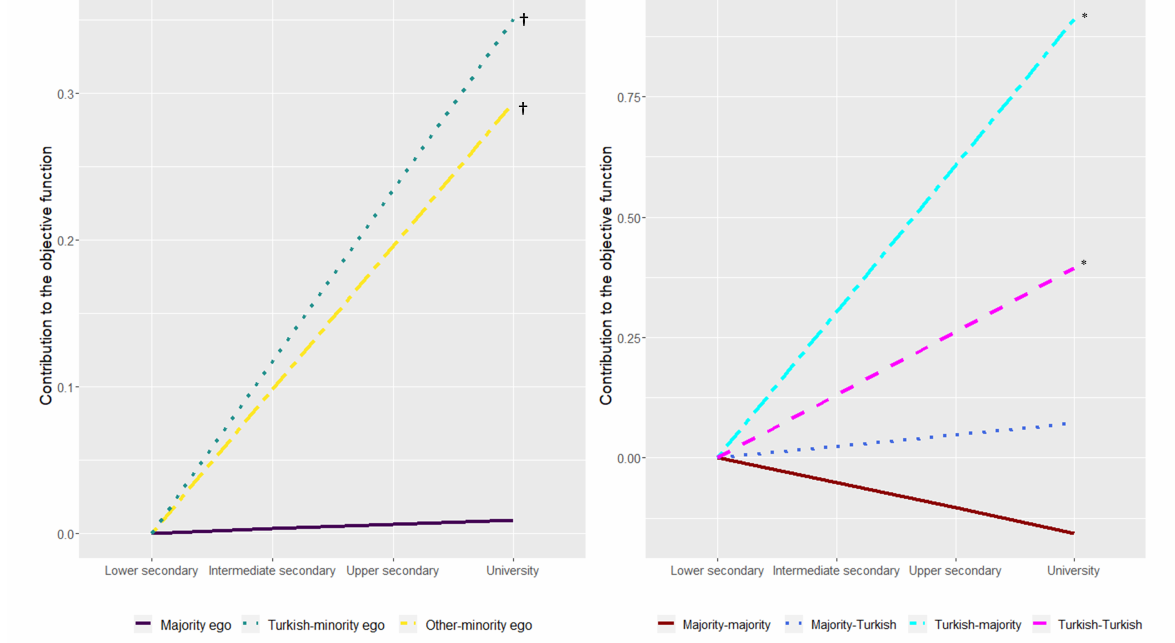
Figure 3: The moderating effects of ego’s (left panel) and ego’s and alter’s (right panel) ethnic background on befriending peers with different educational expectations. Notes: SAOM results from model 1 (left panel) and model 2 (right panel) (the full results are provided in Appendix D of the online supplement). The stars and daggers indicate joint significance for the effect of alter’s educational expectations: † p < 0.01; ∗ p < 0.05. The models achieved sufficient convergence. Sources: CILS4EU, authors’